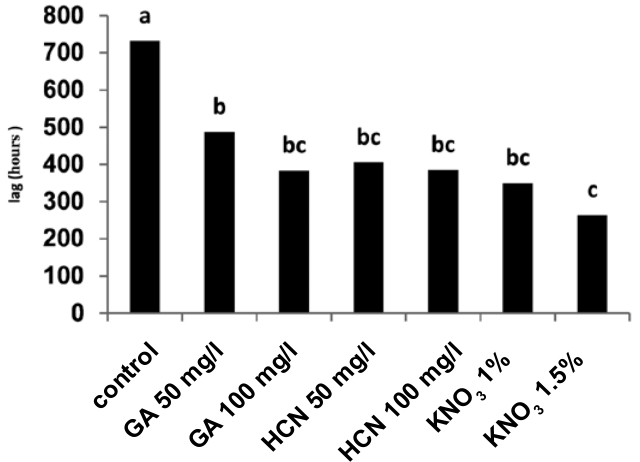
Fig. 1 - Effect of different priming agents on time to germination at onset (lag phase) of Abbasali pistachio variety.